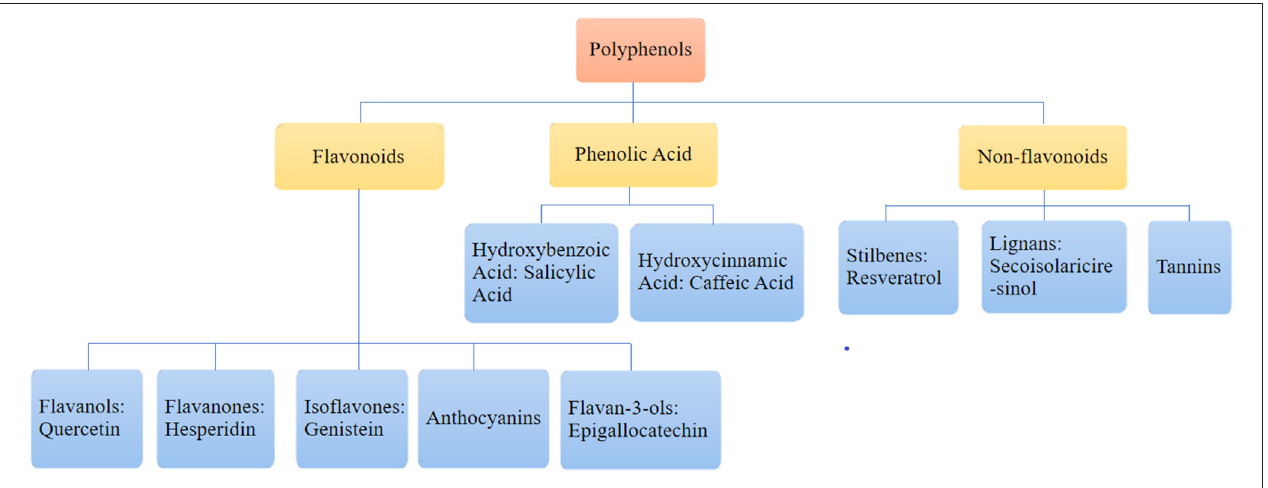
FIGURE 1 | The category of